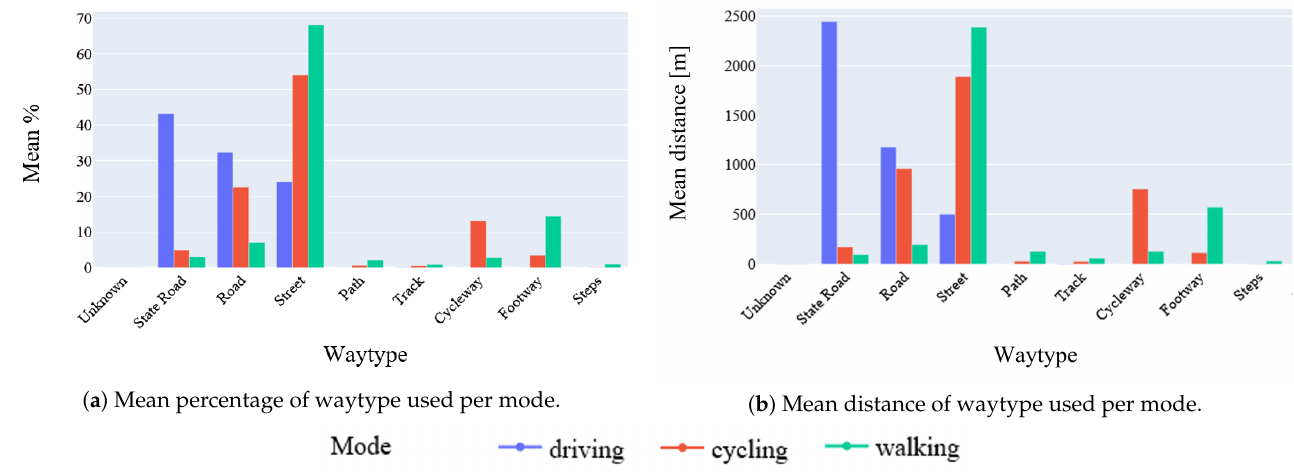
Figure 10. Different average road types (waytype) used per mode for all MSS 2020 trips.